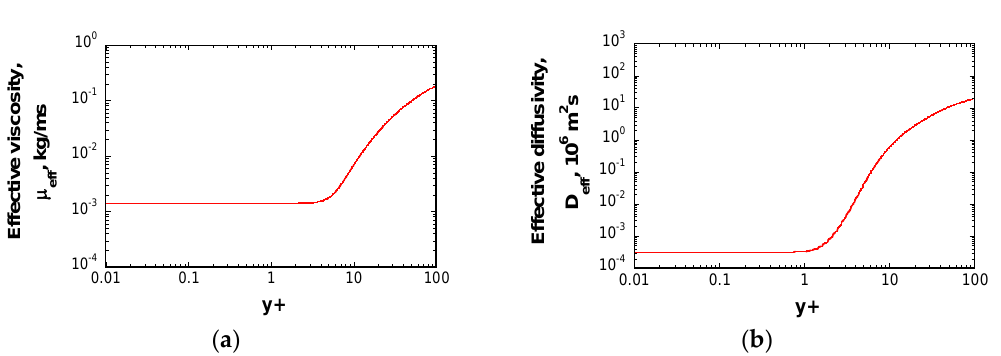
Figure 16. Effective viscosity and effective diffusivity of iron upstream of the reattachment point. ( a ) Effective viscosity; ( b ) Effective diffusivity.